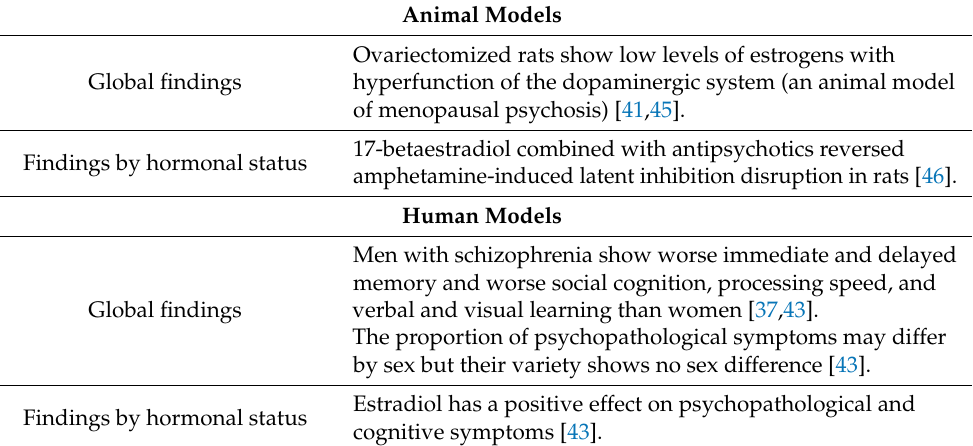
Table 1. Sex differences in psychopathological and cognitive symptoms in schizophrenia.